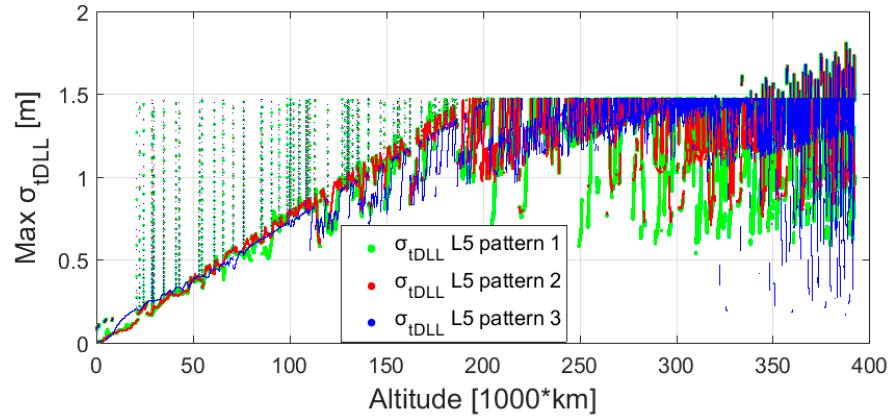
Figure 28. Max code tracking thermal noise range error for the assumed MTO. The thermal noise range error is computed for each available PRN and the max is plotted.